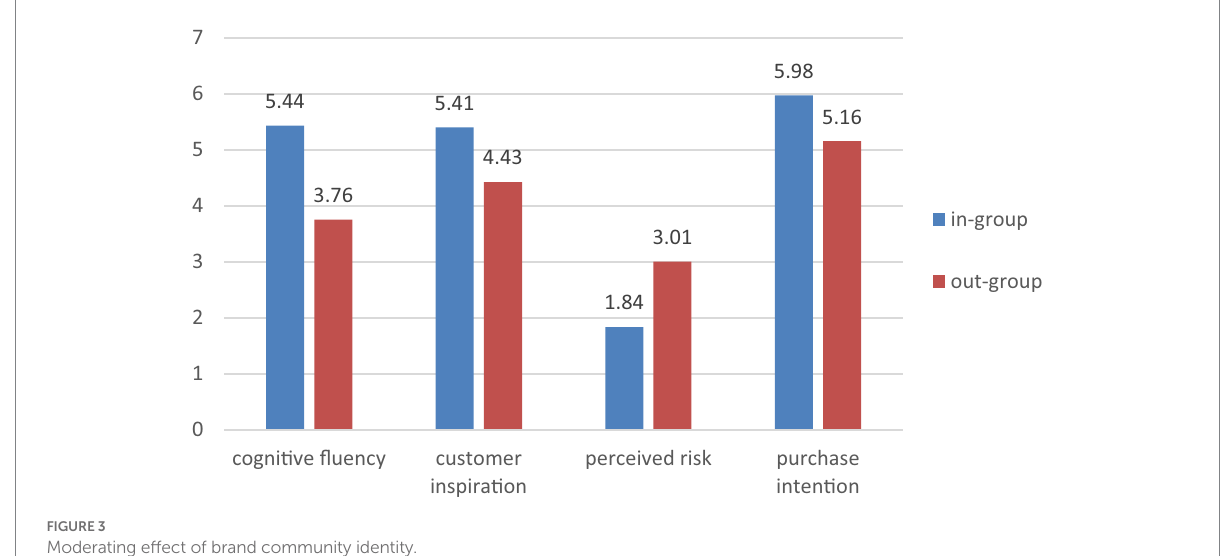
FIGURE 3 Moderating effect of brand community